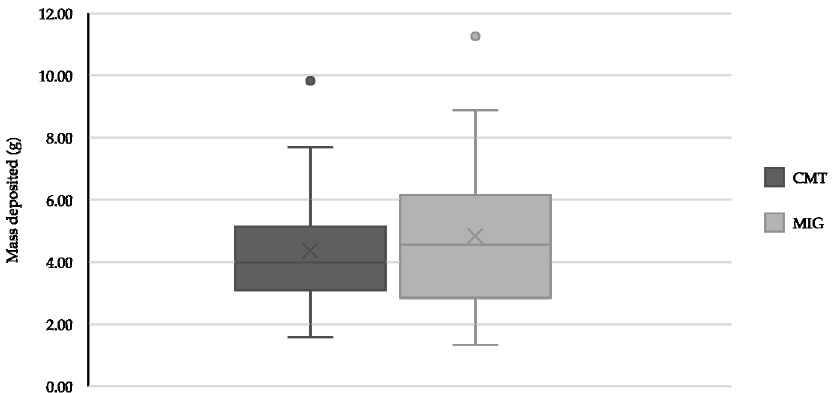
Figure 13. Comparison of material mass deposited throughout all of the parameter sets.